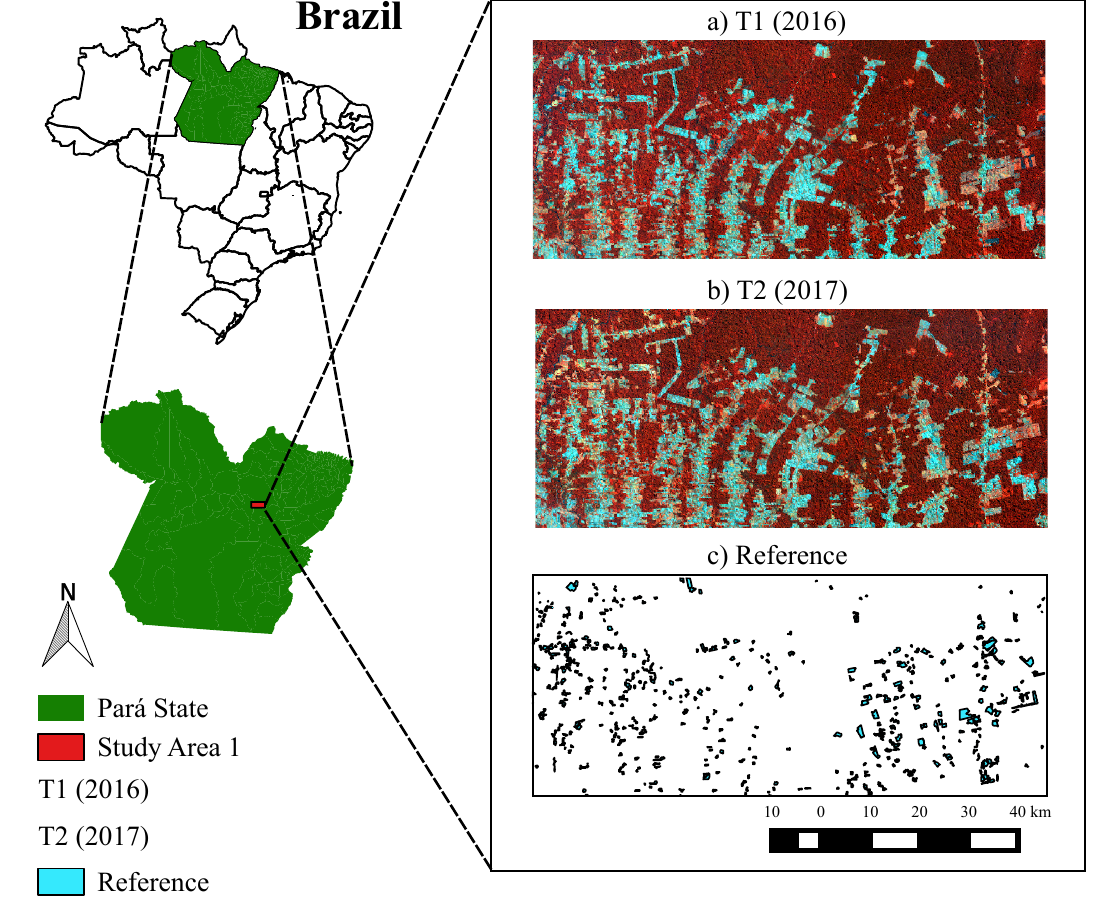
Figure 5. Region of the Brazilian Amazon biome, located in Pará State, Brazil. NIR − G − B composition of the study area at two different dates T1 and T2 ( a , b ); ( c ) Reference of the deforestation process from 2016 to